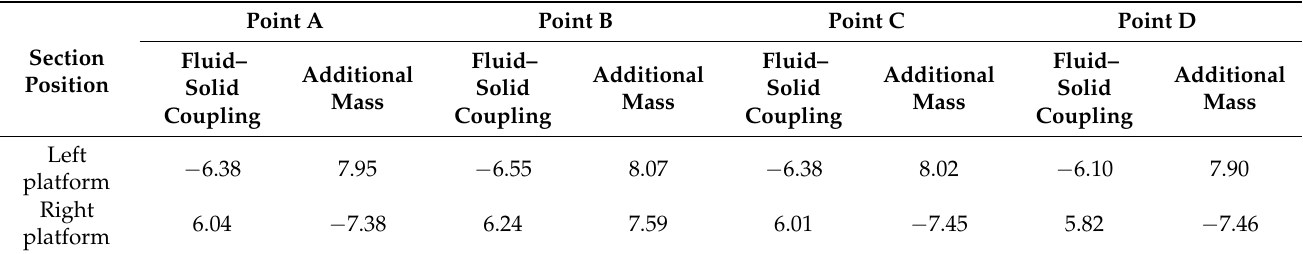
Table 3. Peak acceleration response of the pipe section at the platform (unit: m/s 2